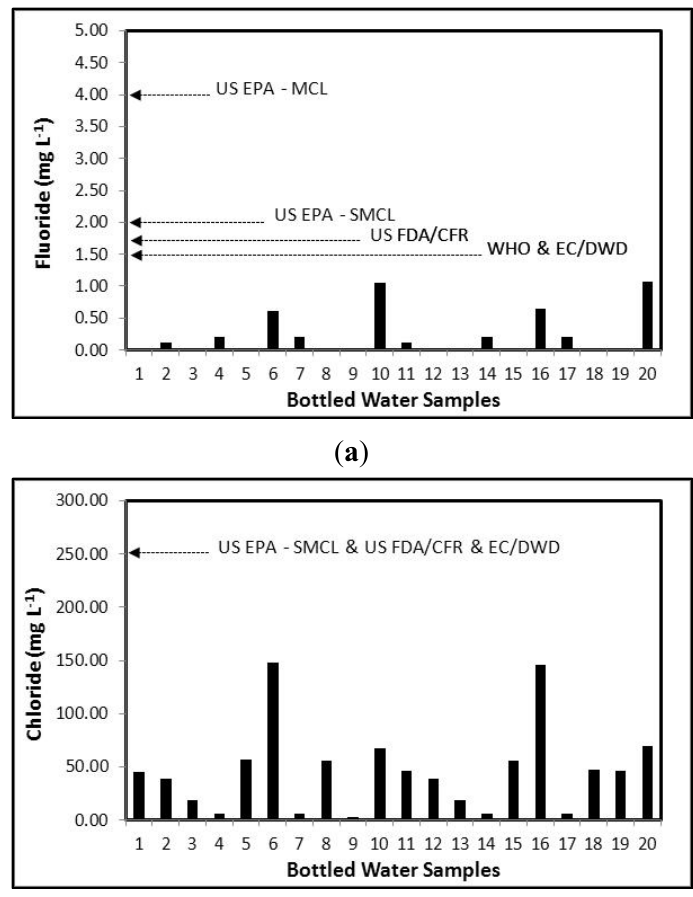
Figure 2. Anion concentrations ( a – e ) measured in the bottled water